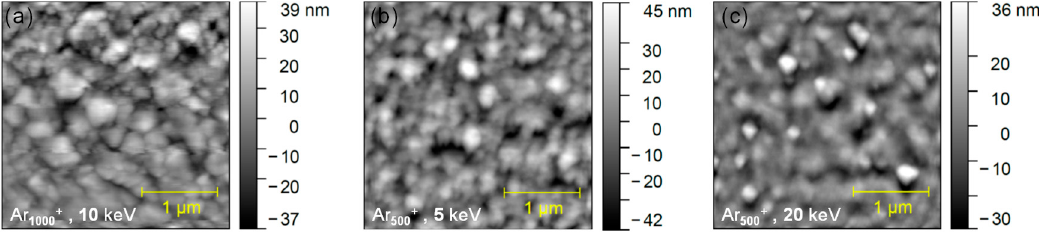
Figure 6. In-situ AFM images acquired in the sputtered crater after 250 s (~210 nm depth) of Ar 1000+ sputtering at 10 keV ( a ), 750 s (~160 nm depth) of Ar 500+ sputtering at 5 keV ( b ), and 40 s (~220 nm depth) of Ar 500+ sputtering at 20 keV ( c ). Monolithic perovskite grains are still visible in ( a ) and